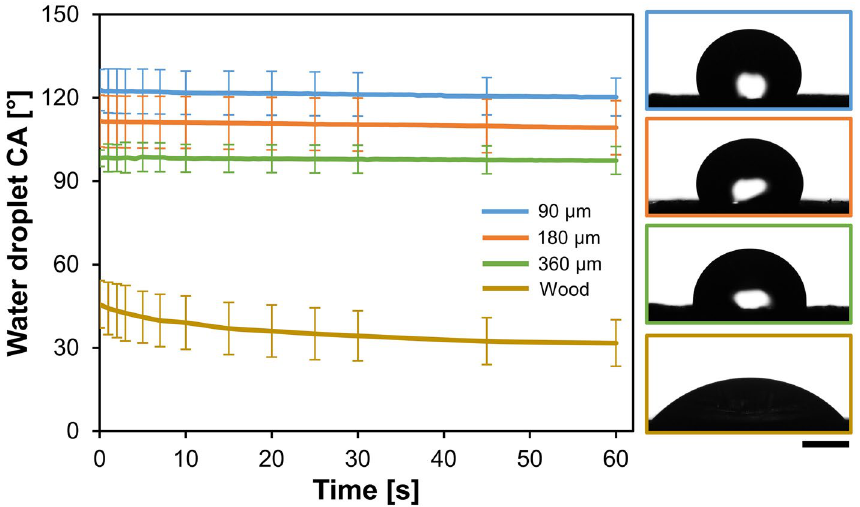
Figure 6. Evolution of water droplets CAs after deposition on the uncoated beech wood surface and on surfaces coated with C + MoO 3 films different thickness. The images on the right show the photos of the water droplets acquired 2 s after deposition on each type of surface. The length of the scale bar is 1 mm.